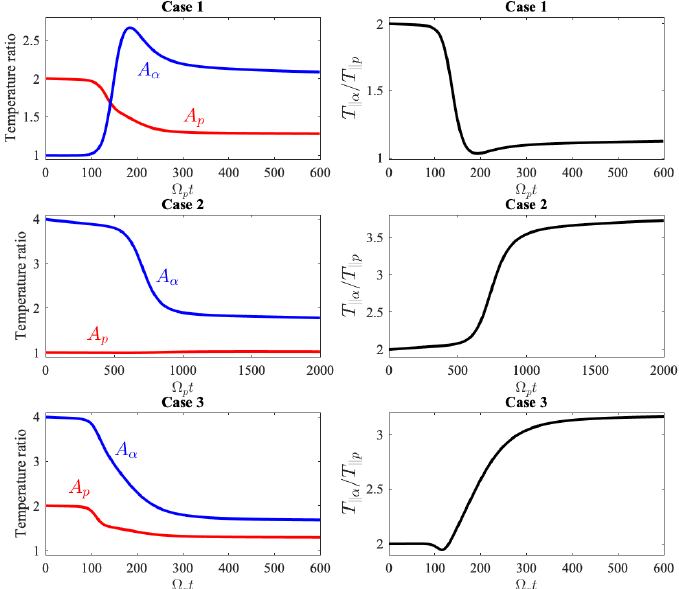
Figure 2. Temporal evolution for cases 1–3: temperature anisotropies ( left column ) and alpha-proton temperature ratio ( right column ). See text for